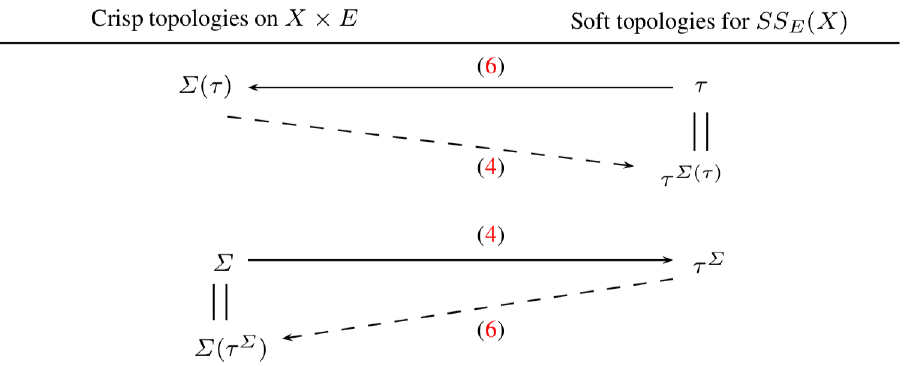
Figure 2. A graphical display of Theorem